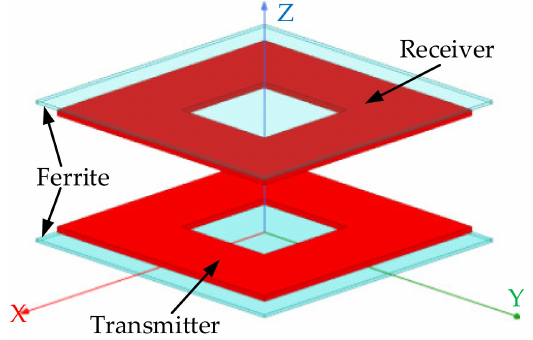
Figure 4. The magnetic coupler of the IPT